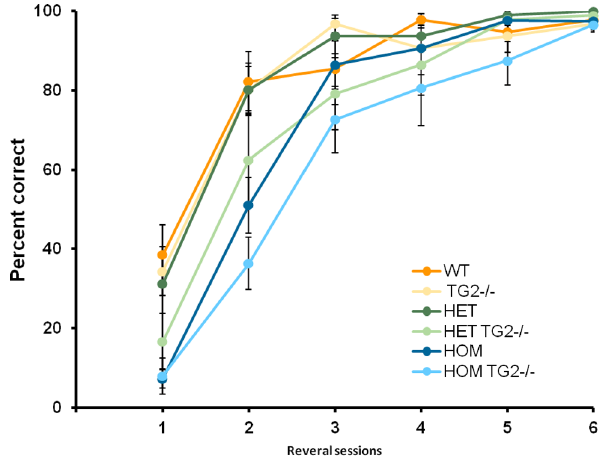
Figure 8. Reversal phase of the procedural T–maze task (platform location switched; n=11–12 per genotype). WT: wild-type, TG2 2 / 2 : homozygous TG2 knockout, HET: zQ175 HET, HOM: zQ175 HOM.